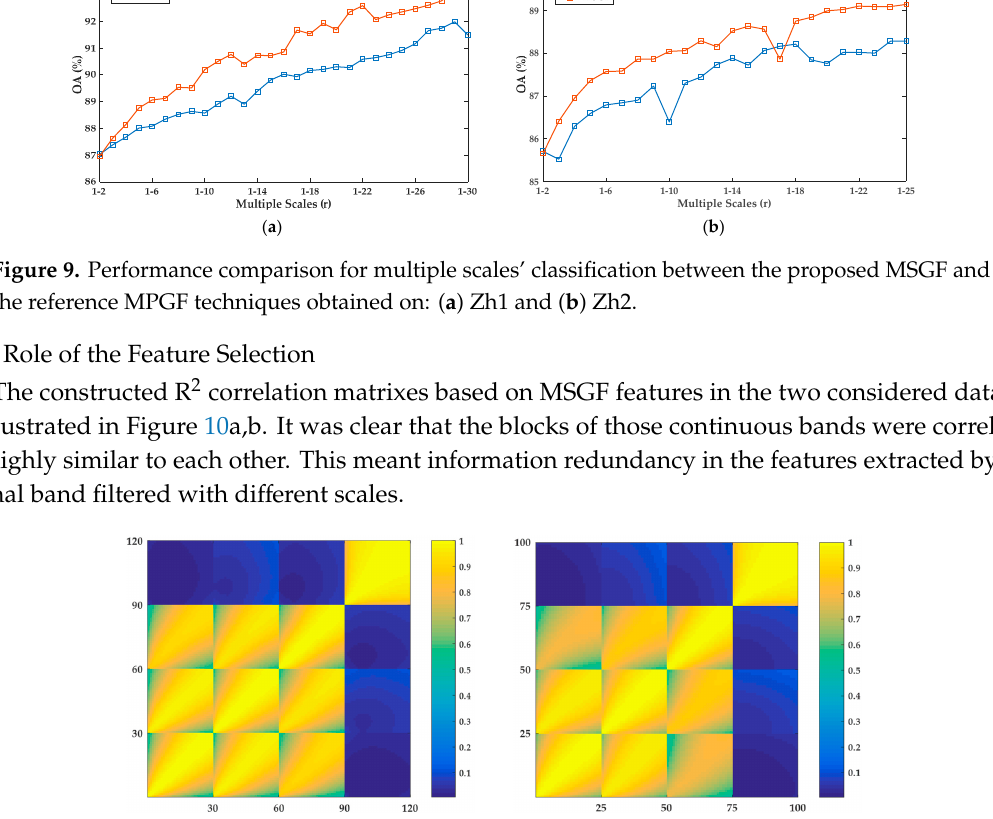
Figure 10. The R 2 correlation matrixes of MSGF features generated on: ( a ) Zh1; and ( b ) Zh2.